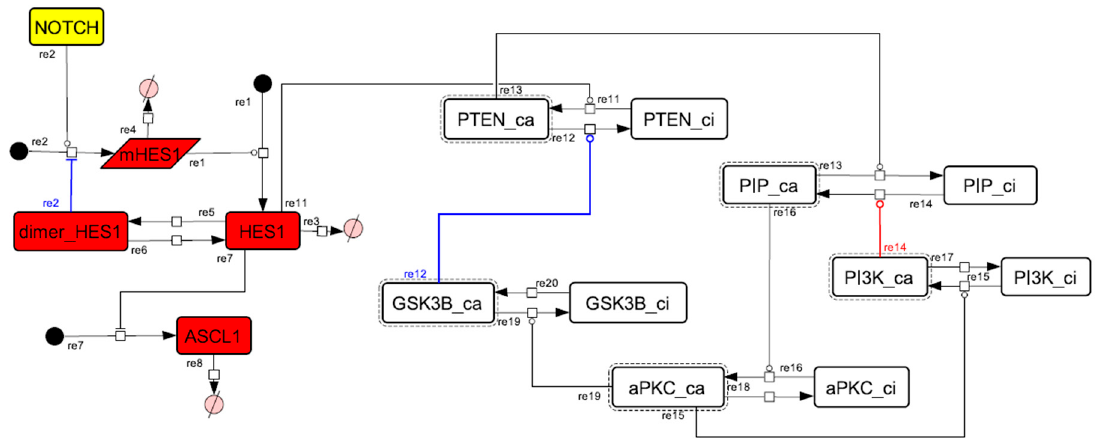
Figure A11. Diagram of the collapsed model of the negative-feedback loop between beta-catenin and HES1. Table A1. Nodes removed by the contraction process.